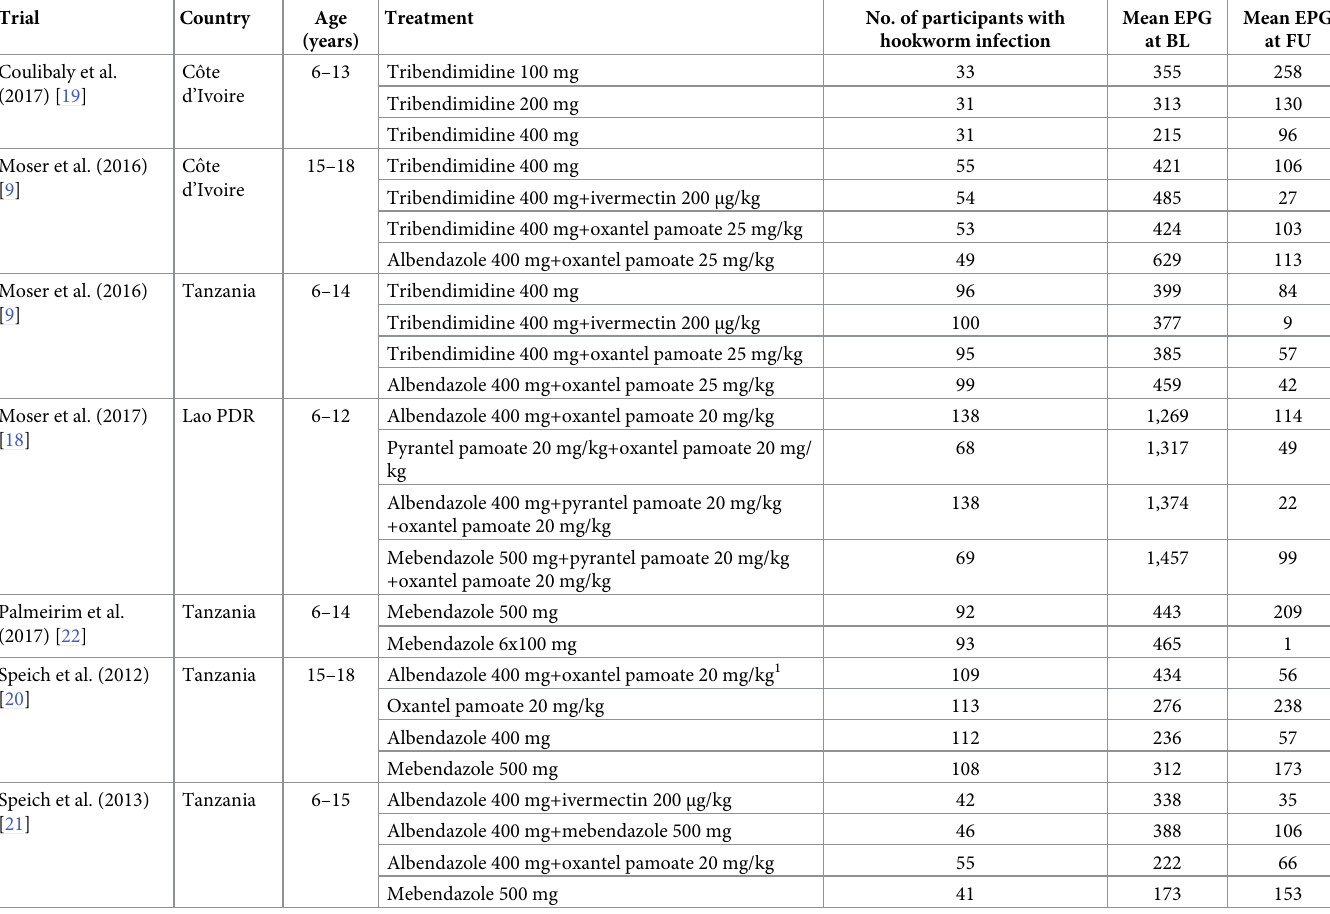
Table 1. Description of trial data: Age group included, treatments tested, sample sizes and arithmetic mean of averaged egg counts per gram of stool (EPG) averaged on the four slides at baseline (BL) and follow-up (FU).